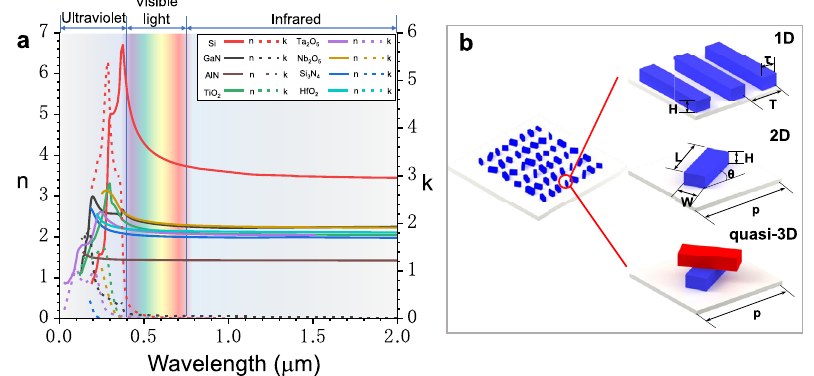
Figure 1: Materials and general design of all- dielectric metasurfaces. (a) The complex refractive index of the typical dielectric materials for constructing all-dielectric metasurfaces in different optical wave- length bands. (b) Schematics of all- dielectric metasurfaces for polarization